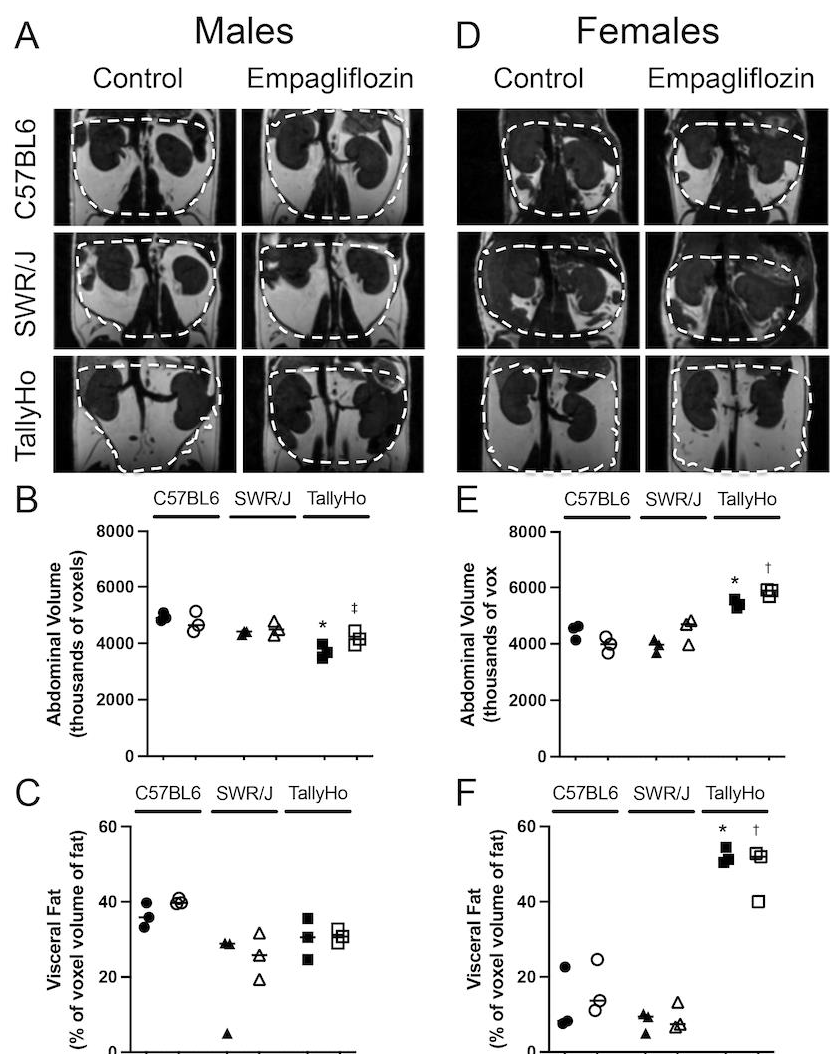
Figure 2. Empagliflozin does not change visceral fat volume. Male and Female TallyHo (squares), SWR/J (triangles), and C57BL6J (circles) were fed a high milk-fat diet in the absence (filled symbols) or presence (open symbols) of 10 mg/kg BW Empagliflozin. MRI was performed to detect changes in visceral adiposity. Representative images of the abdominal region from male ( A ) and female ( D ) mice highlight the area quantified (dashed lines). ( B , E ) The total volume of the abdomen was quantified and graphed as thousands of voxels. ( C , F ) Within the abdominal region, the total volume of visceral fat was calculated. Two-way ANOVA with multiple comparisons was performed. * p < 0.05 TallyHo control mice vs. C57BL6J and SWR/J; † p < 0.05 TallyHo Empagliflozin vs. C57BL6J and